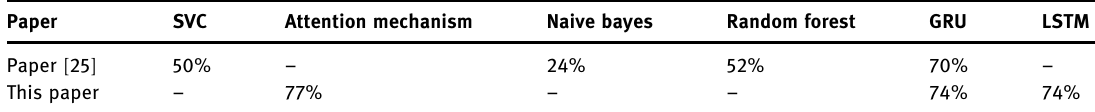
Table 3: Comparing algorithm among multi - class labels Paper